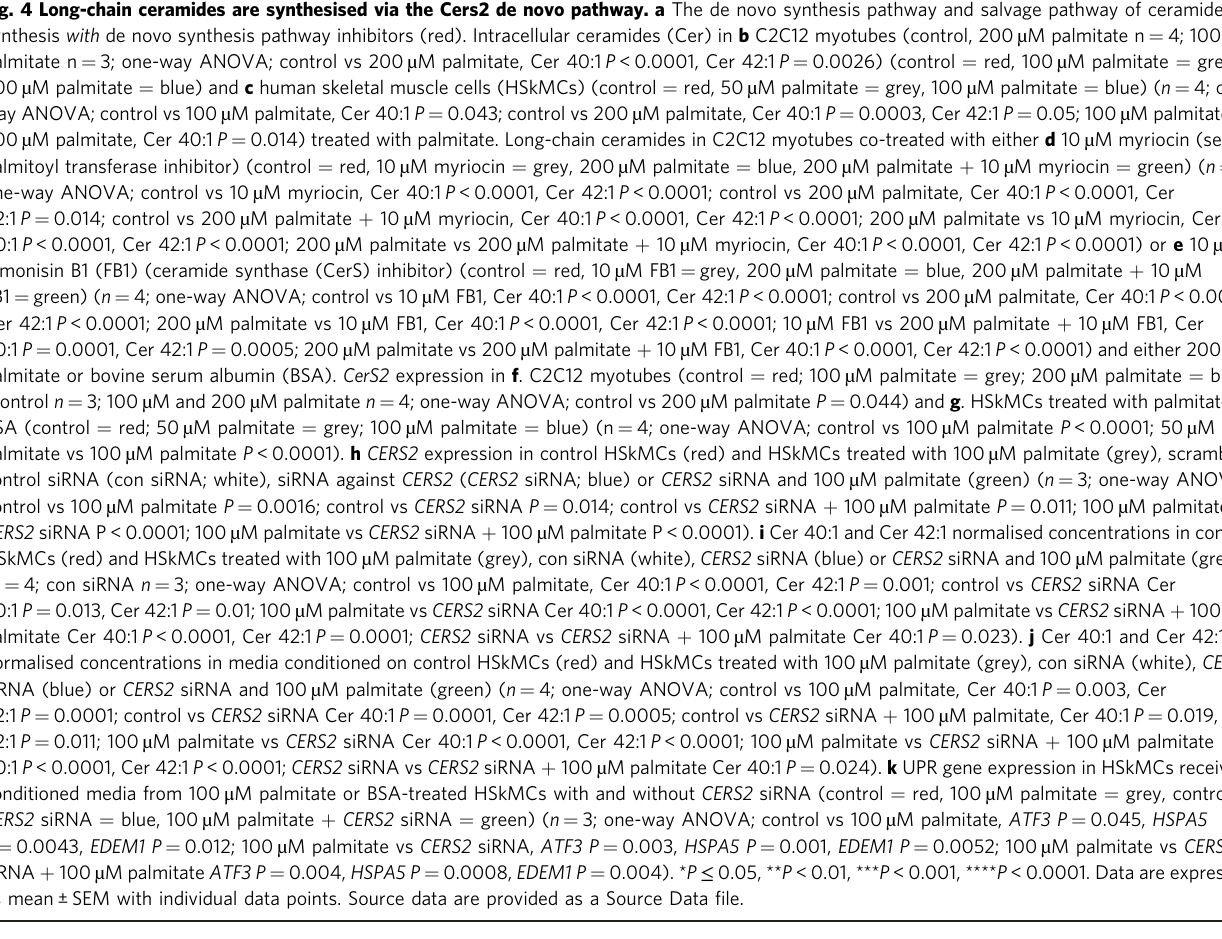
Fig. 4 Long-chain ceramides are synthesised via the Cers2 de novo pathway. a The de novo synthesis pathway and salvage pathway of ceramide synthesis with de novo synthesis pathway inhibitors (red). Intracellular ceramides (Cer) in b C2C12 myotubes (control, 200 µ M palmitate n = 4; 100 µ M palmitate n = 3; one-way ANOVA; control vs 200 µ M palmitate, Cer 40:1 P < 0.0001, Cer 42:1 P = 0.0026) (control = red, 100 µ M palmitate = grey, 200 µ M palmitate = blue) and c human skeletal muscle cells (HSkMCs) (control = red, 50 µ M palmitate = grey, 100 µ M palmitate = blue) ( n = 4; one- way ANOVA; control vs 100 µ M palmitate, Cer 40:1 P = 0.043; control vs 200 µ M palmitate, Cer 40:1 P = 0.0003, Cer 42:1 P = 0.05; 100 µ M palmitate vs 200 µ M palmitate, Cer 40:1 P = 0.014) treated with palmitate. Long-chain ceramides in C2C12 myotubes co-treated with either d 10 µ M myriocin